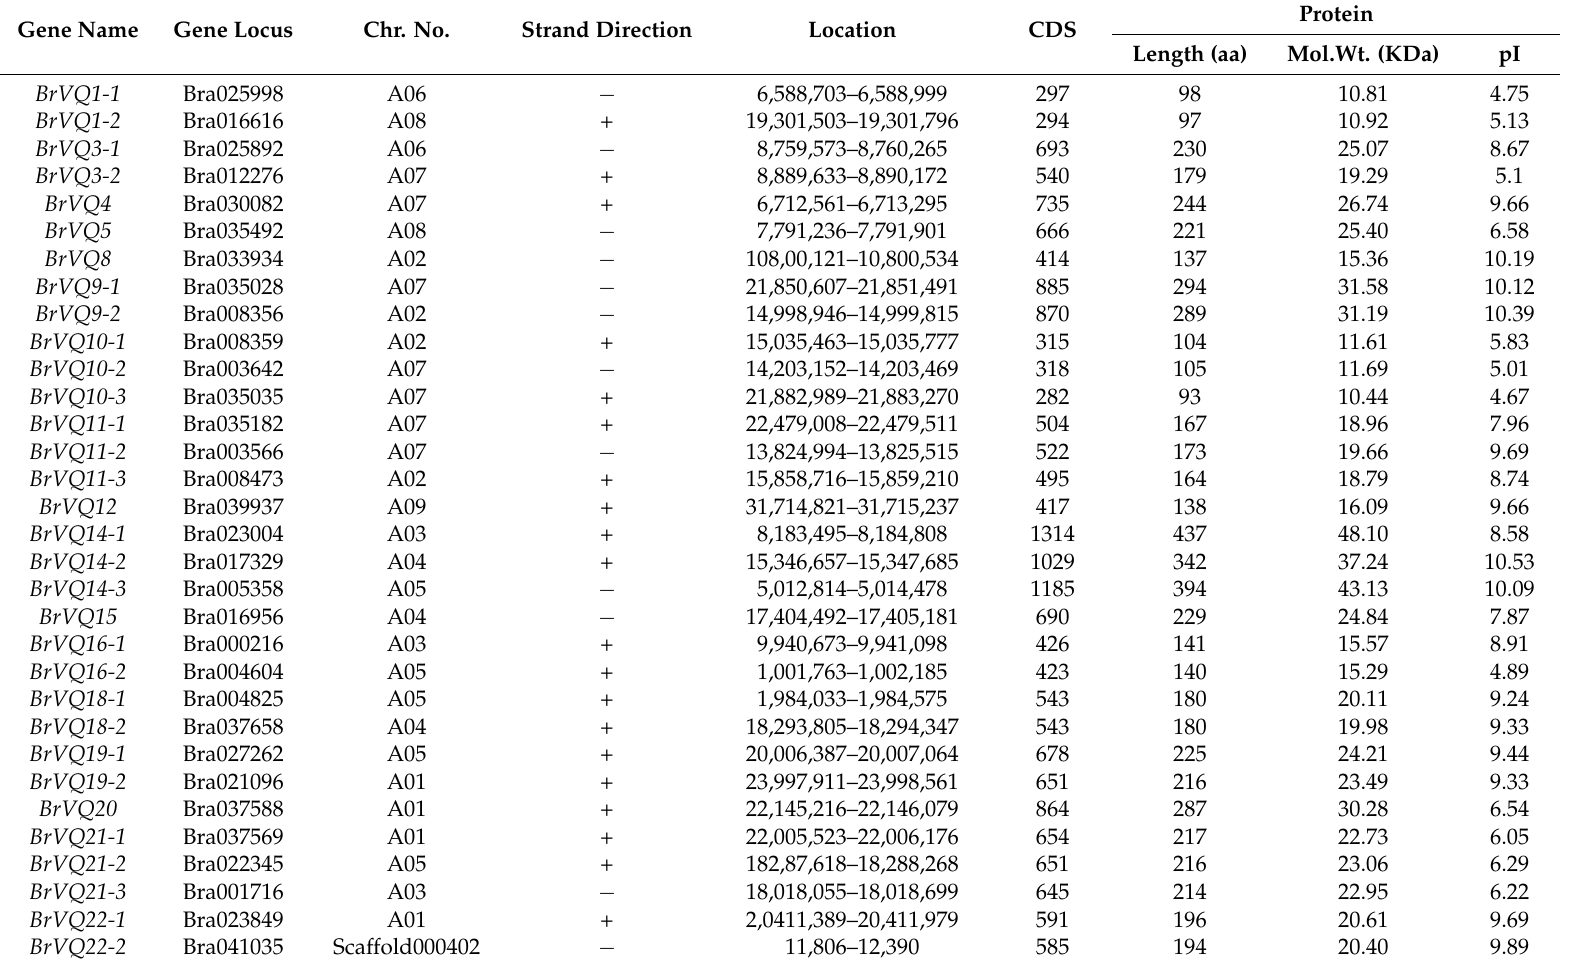
Table 1. Properties of the Chinese cabbage VQ genes and